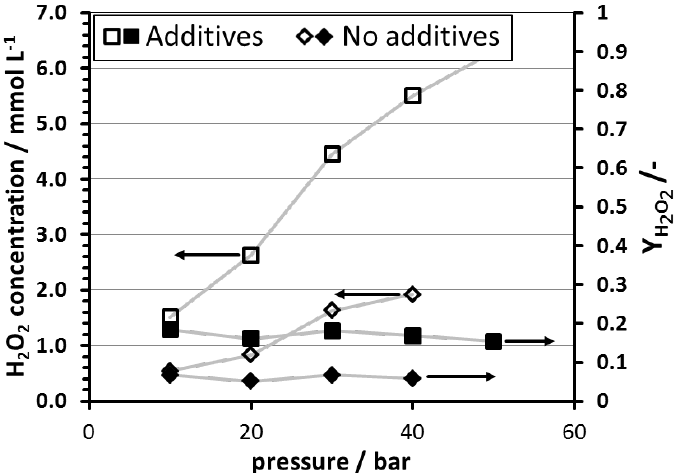
Figure 4. Hydrogen peroxide concentration (empty symbols) and hydrogen peroxide yield (filled symbols) over system pressure using Pd/TiO 2 in a micro channel fixed bed in a 0.5 mm deep micro channel and a 180 μm Nafion ® membrane with a solvent flow rate of 0.5 mL/min and water as solvent: squares: 4 mM NaBr, 0.15 mM H 2 SO 4 (Table 1 Exp.-Nr.: 29–33), diamonds: no additives (Table 1 Exp.-